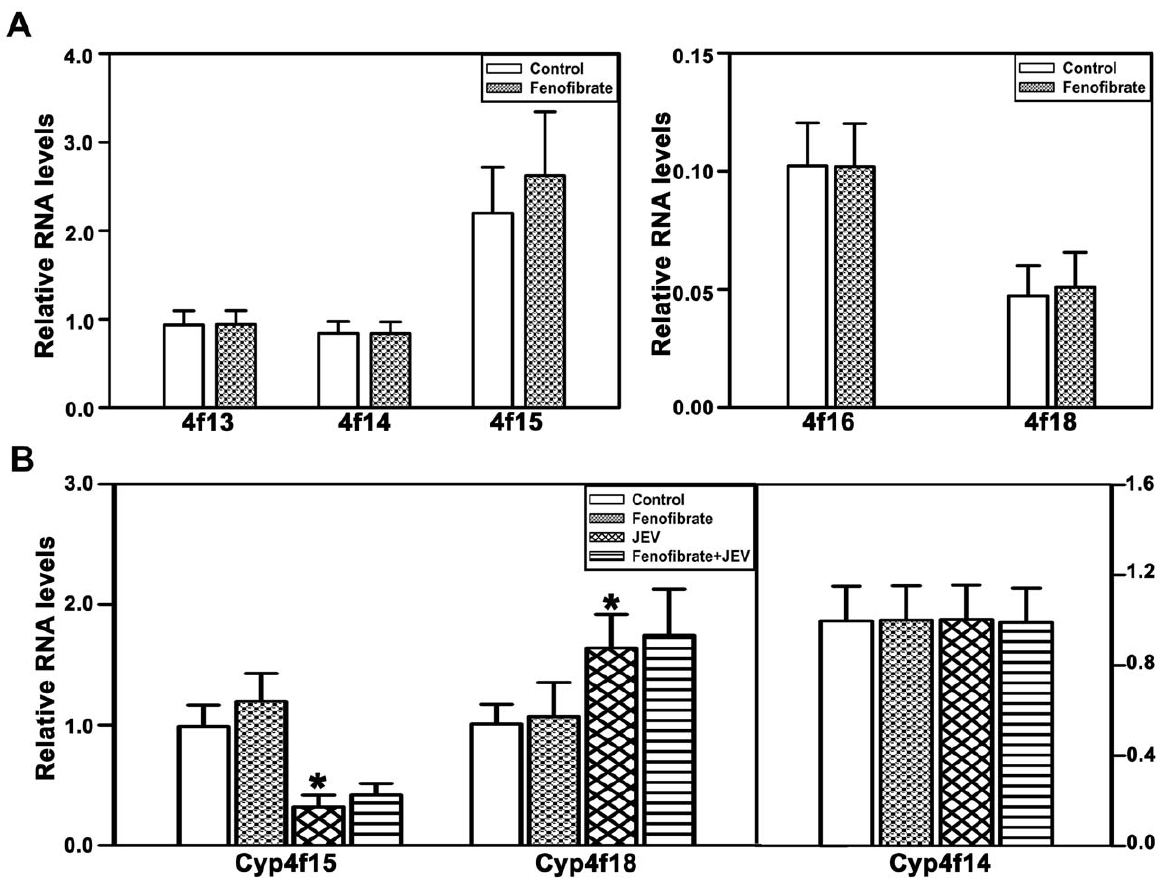
Figure 8. Cyp4fs were not induced following 2 days of fenofibrate pretreatment. (A) There was no change in the expression of Cyp4f13, 14, 15, 16 and 18 in mouse cortex following fenofibrate treatment for 2 days. mRNA levels of all Cyp4fs are expressed relative to control Cyp4f13 levels. (B) Pretreatment with fenofibrate did not enhance the levels of Cyp4f15 and 18 compared to mice exposed to JEV alone. mRNA levels for all treatments are expressed relative to controls (n=8 per group, *and # p , 0.05).